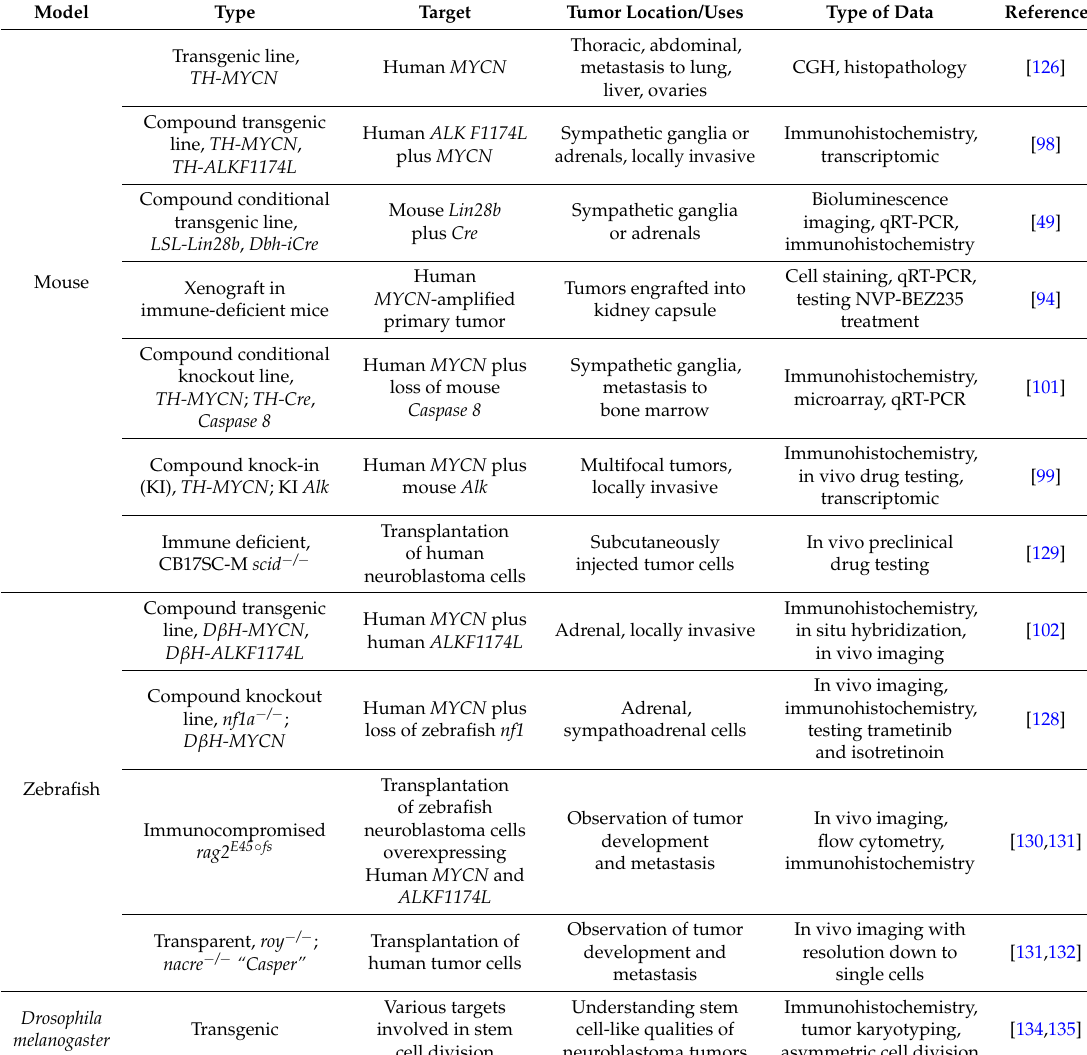
Table 3. Animal models of neuroblastoma. Table adapted from Zhu, 2016 [127], and expanded. ALK: anaplastic lymphoma kinase; CGH: comparative genomic